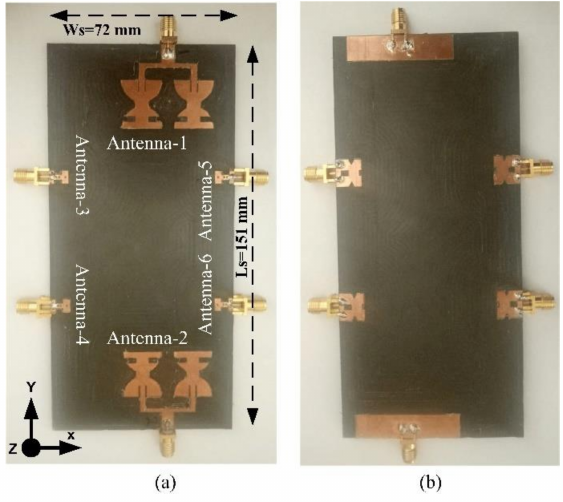
Figure 8. Hardware prototype for the integrated design: ( a ) front view; ( b ) back